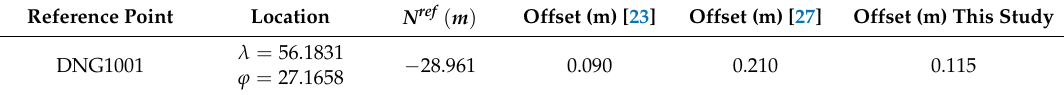
Table 5. The estimated offset of the geoid at the DNG1001 point for the levelling network of